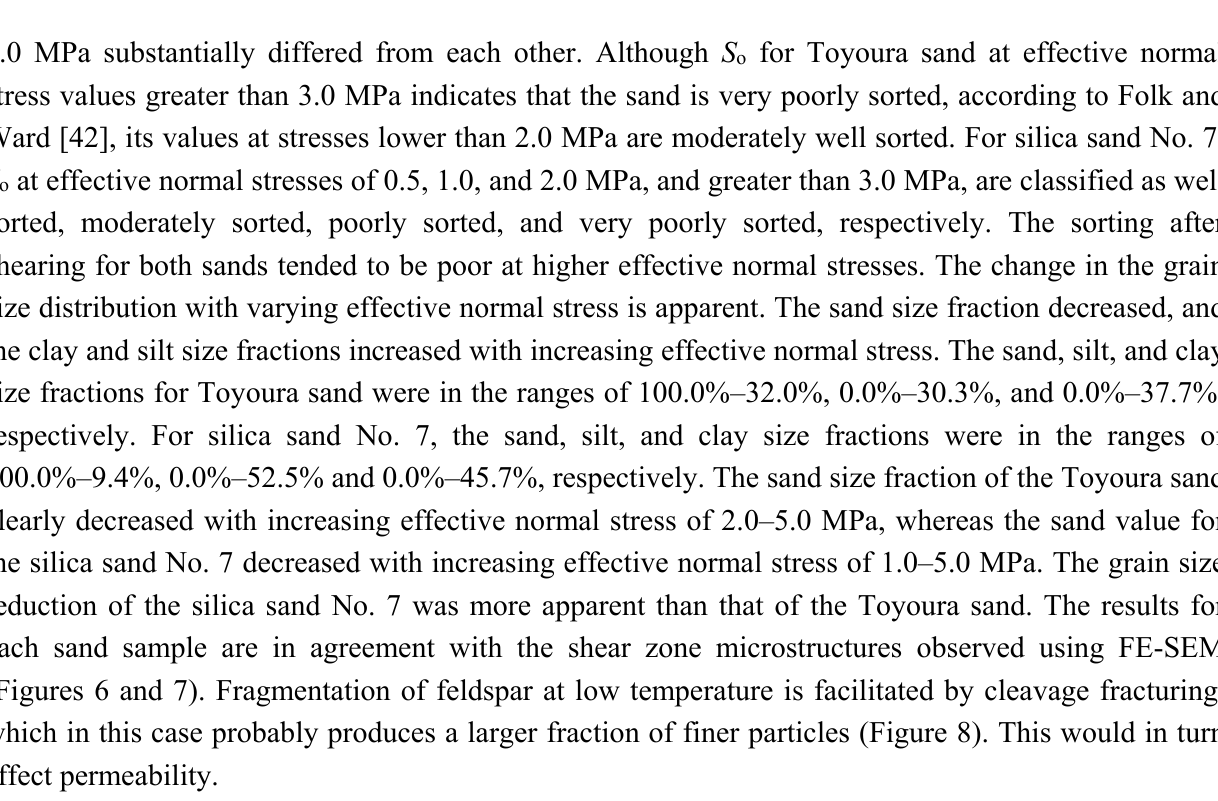
Table 3. Grain size distribution, median, and sorting in shear zones of specimen after ring-shearing. Effective Normal